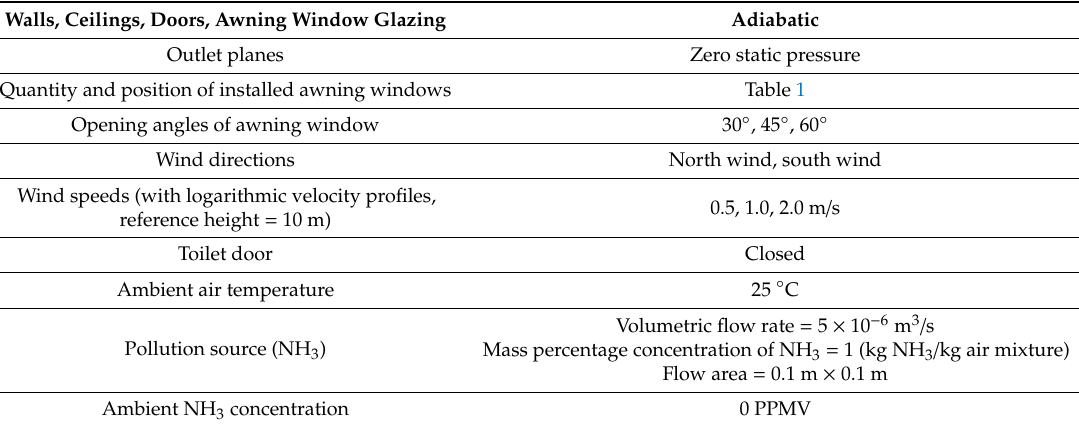
Table 3. Parameters specified in numerical